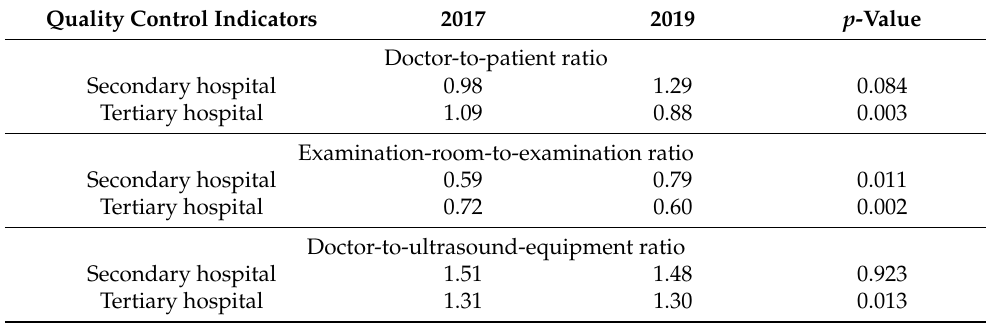
Table 3. Performance in quality control indicators in enrolled hospitals classified by hospital